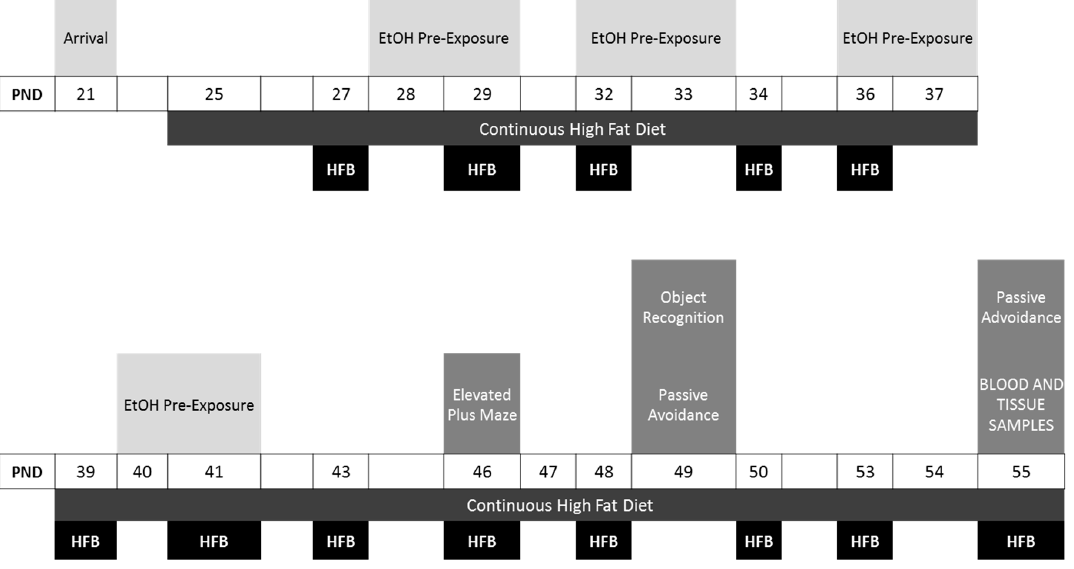
Figure 1. Experimental design. Abbreviations: EtOH, ethanol; HFB,